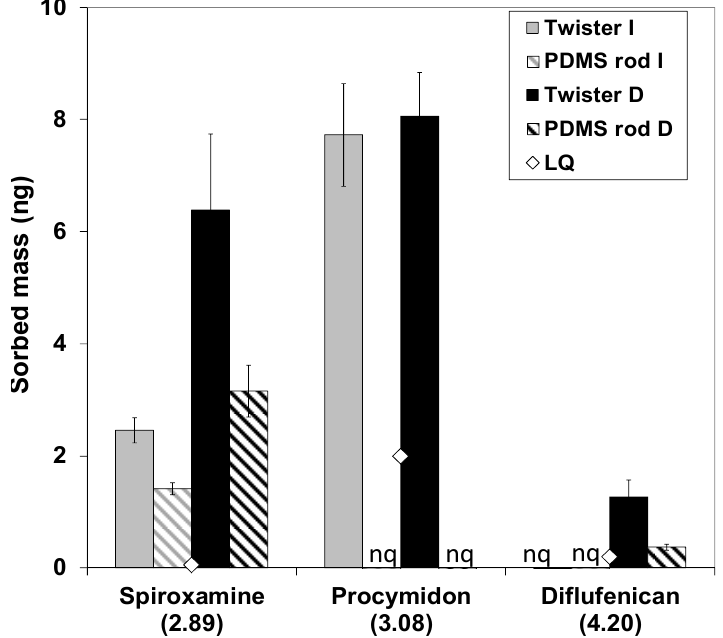
Figure 3. Comparison of the amounts of pesticides accumulated in Twisters and PDMS rods exposed in river water for two weeks. “LQ” is the quantification limit in ng for both devices. “nq” stands for non-quantified, “I” stands for the intermediary sampling site and “D” stands for the downstream sampling site. Numbers in brackets on the x axis are the octanol-water partitioning coefficients of the quantified pesticides (log K increasing values. Errors bars represent ± standard deviation ( n =